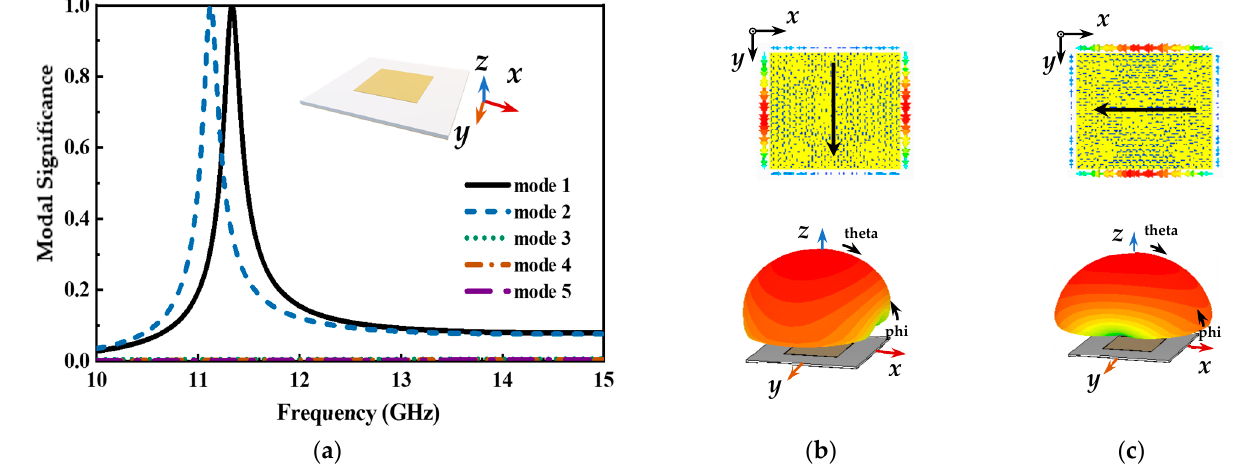
Figure 8. Modal behaviors of the top substrate and radiation patch, ( a ) modal significance, ( b ) the modal current and far-field radiation pattern of mode 1, and ( c ) the modal current and far-field radiation pattern of mode 2. Modal Significance.